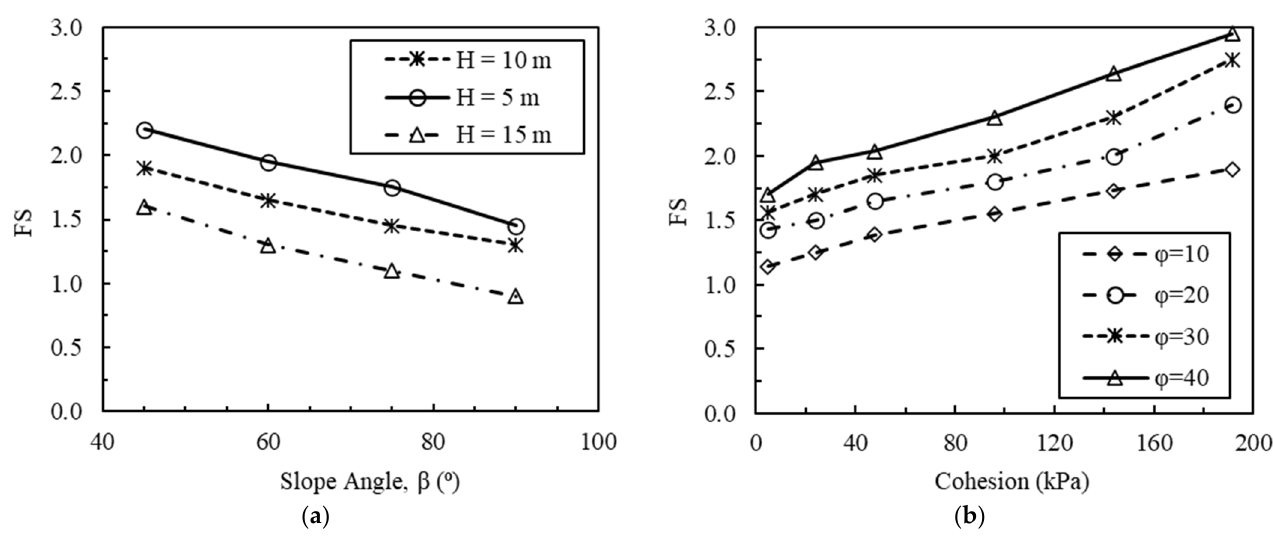
Figure 11. Effect of ( a ) slope height and ( b ) cohesion and friction angle on the stability of nailed slope.